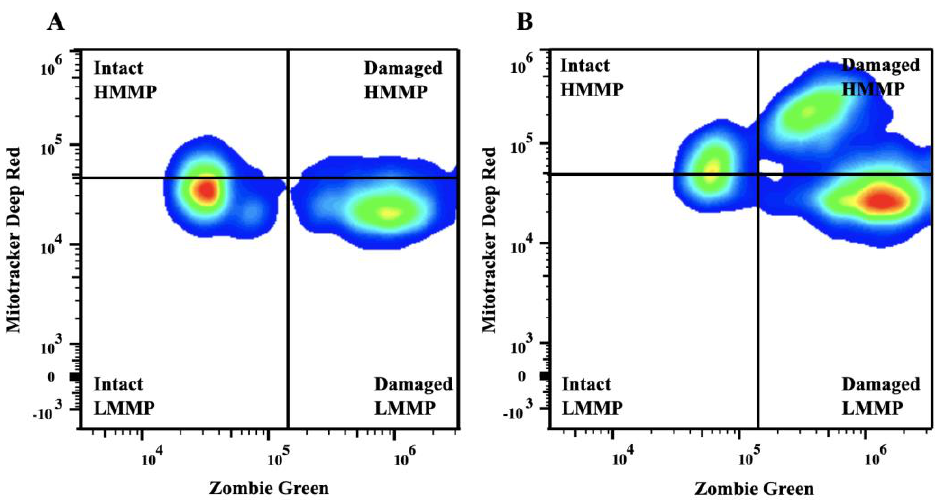
Figure 1. Representative flow cytometry plots of semen collected from a breeding inactive stallion before ( A ) and after ( B ) freezing. Sperm were stained with Zombie Green and MitoTracker Deep Red. The upper quadrants represent intact ( left ) and damaged ( right ) sperm with high mitochondrial membrane potential. The lower quadrants represent intact ( left ) and damaged ( right ) sperm with low mitochondrial membrane potential. Abbreviations: Intact, sperm with intact plasma membrane; HMMP, intact sperm with high mitochondrial membrane potential; LMMP, intact sperm with low mitochondrial membrane potential.